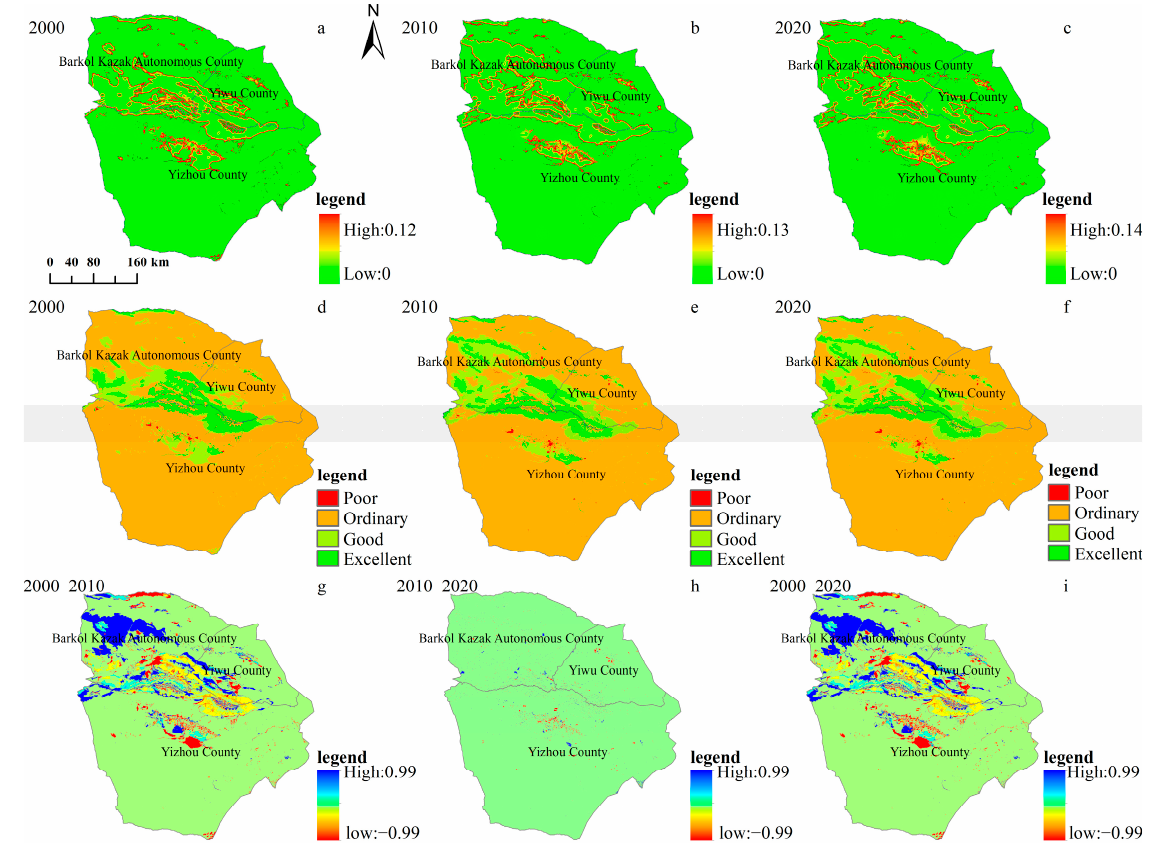
Figure 6. Habitat degradation degree, classes and changes in Hami city from 2000 to 2020: ( a – c ) habitat degradation, ( d – f ) habitat classes, ( g – i ), habitat changes.